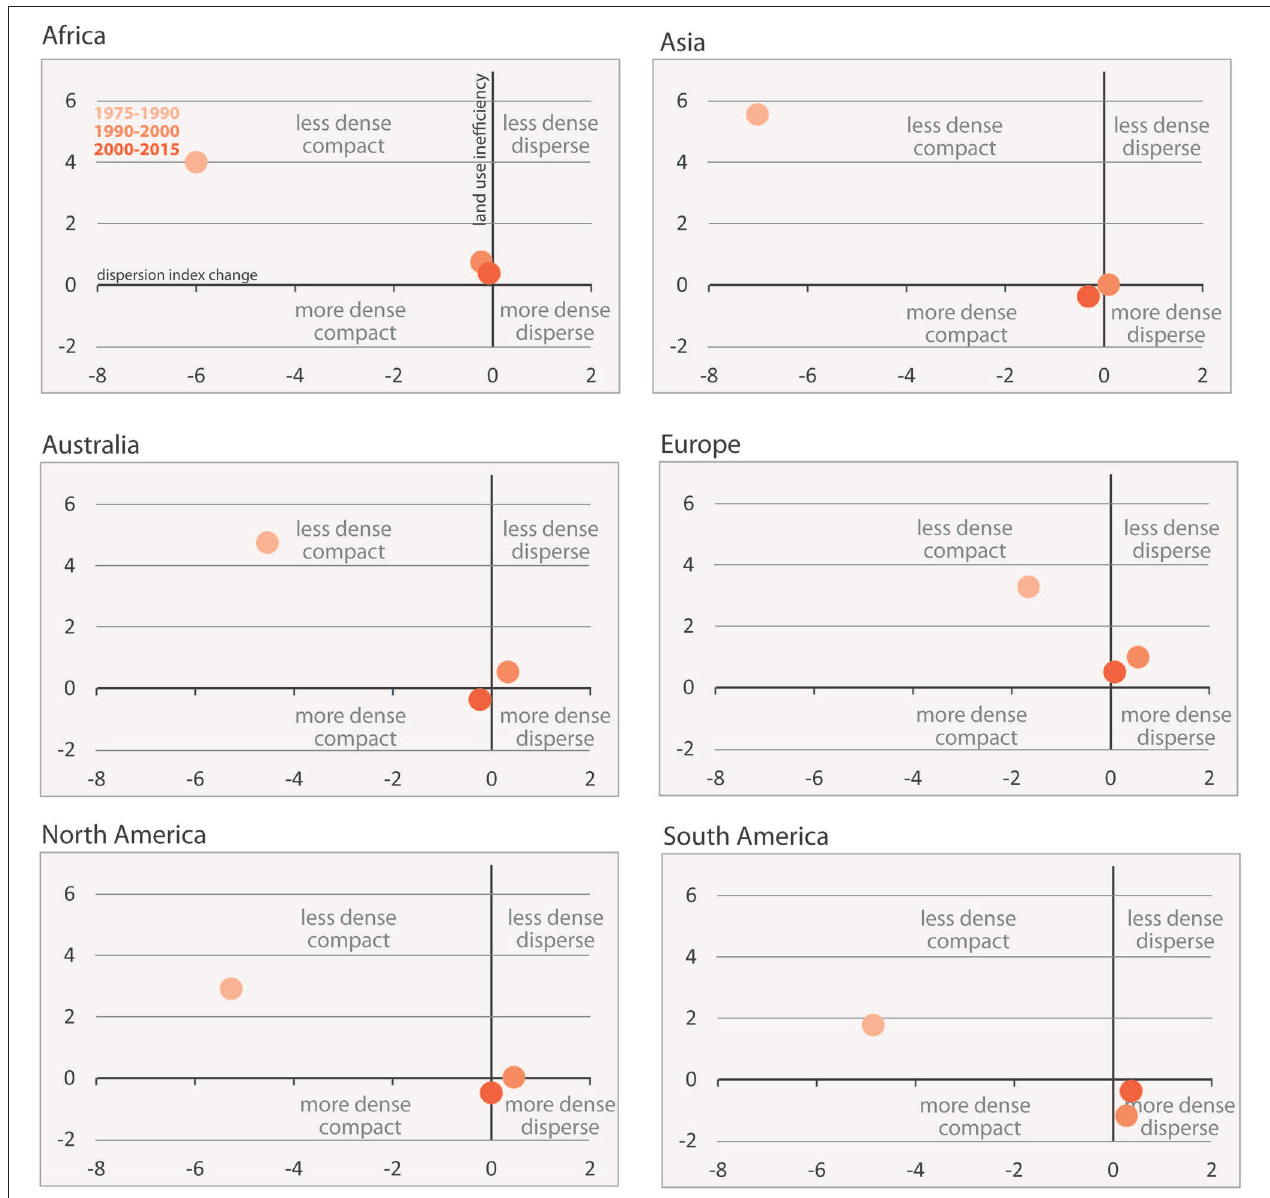
FIGURE 4 | Urbanization trends for the continents.